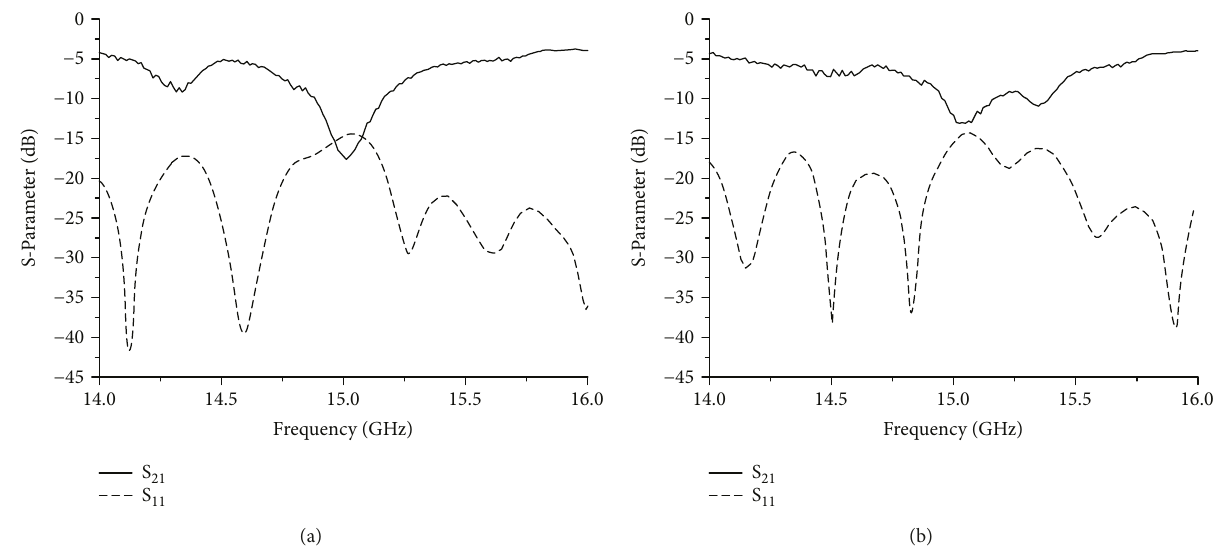
Figure 13: The fabricated sample and measured S-parameters of the antenna arrays: (a) Con fi guration 1; (b) Con fi guration 2. −1010 0